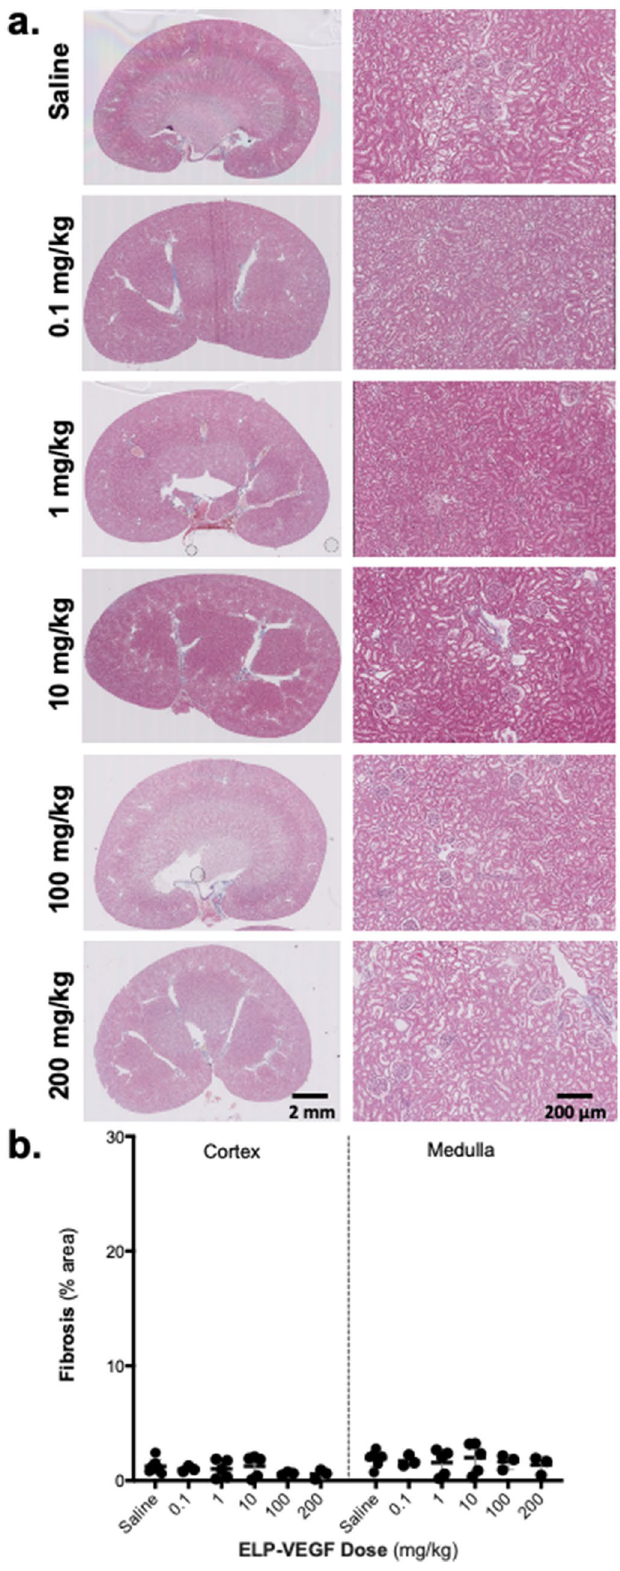
Figure 5. Renal Histology Following ELP-VEGF Therapy. (a) Renal sections taken from kidneys on Day 14 after ELP-VEGF injection were stained with Masson’s trichrome to assess renal fibrosis. (left bar = 2 mm, right bar = 200 µm). (b) Percentage fibrotic area was measured from each treatment